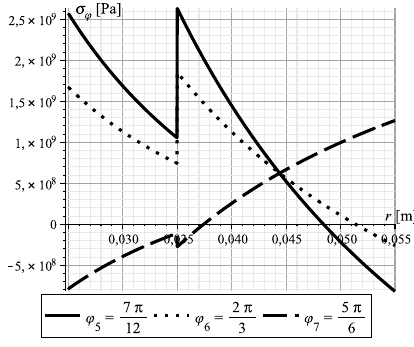
Figure 20: Plot of σ φ as a function of r for φ i ( i = 1 . . . 4) (Example 5.2).